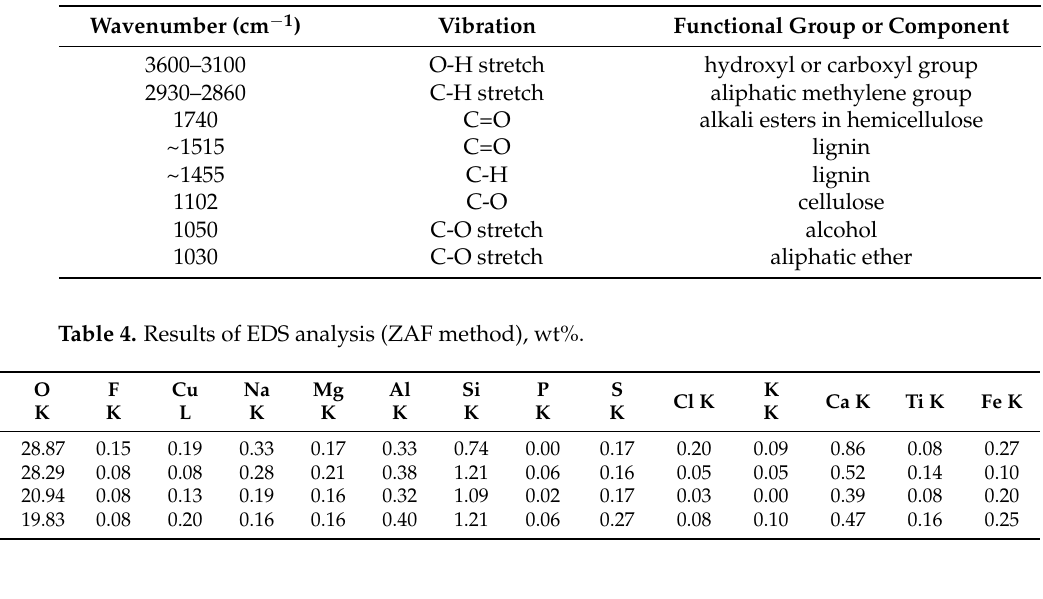
Table 3. Indicator bands, their vibrations, and corresponding functional groups.